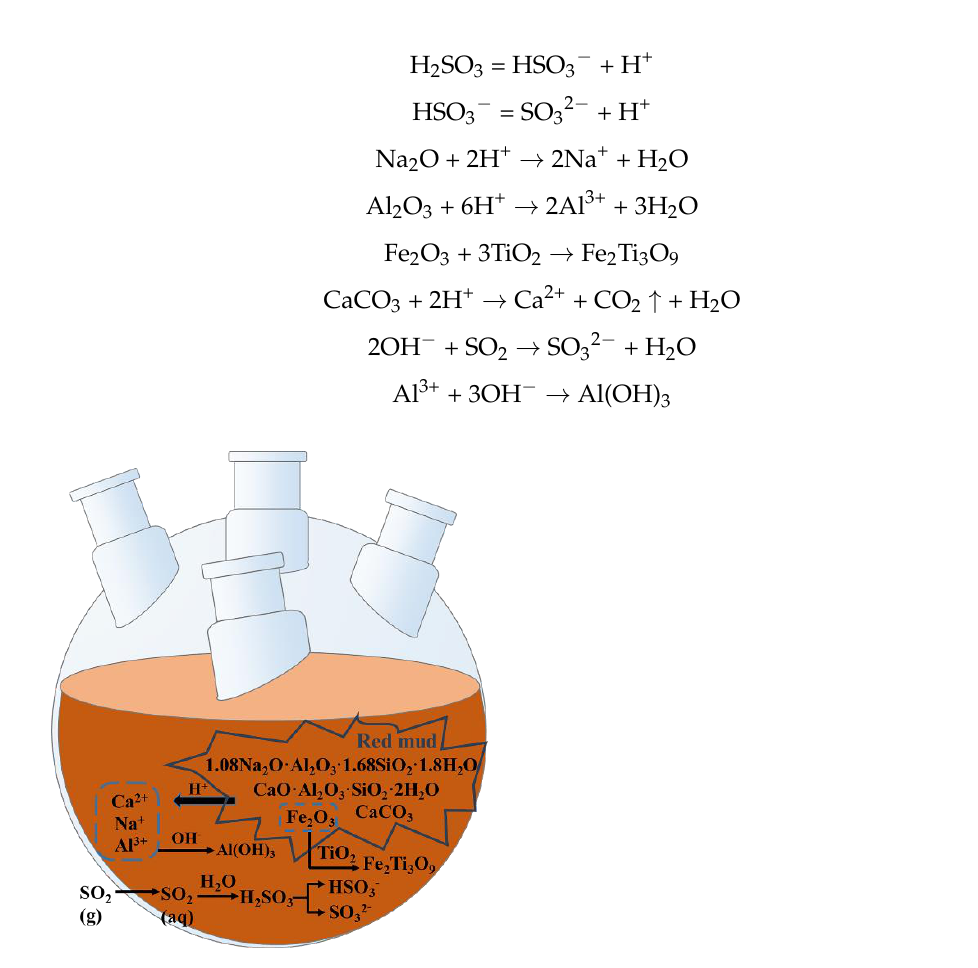
Figure 11. Mechanism of red mud desulfurization in the